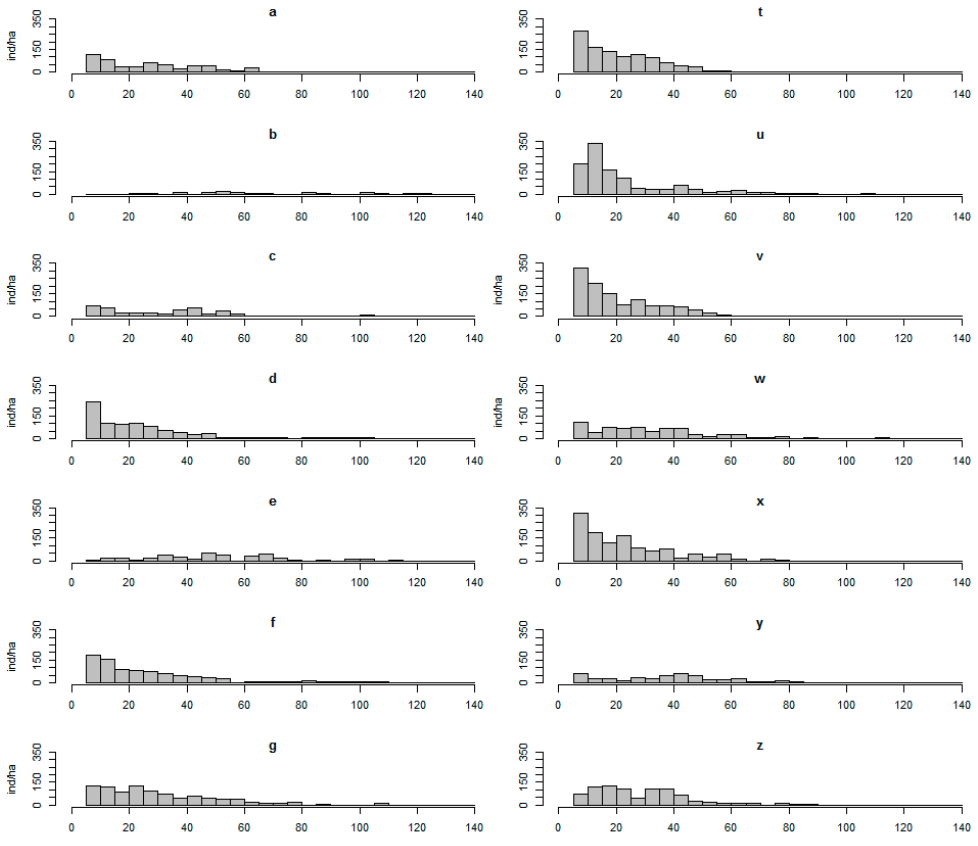
Figure 2. Diameter distributions of the sampled plots. ( a – g ) Old-growth forest; ( t – z ) secondary forest. Letters correspond to plots, as described on Table 1. Remote Sens. 2021 , 13 , x FOR PEER REVIEW